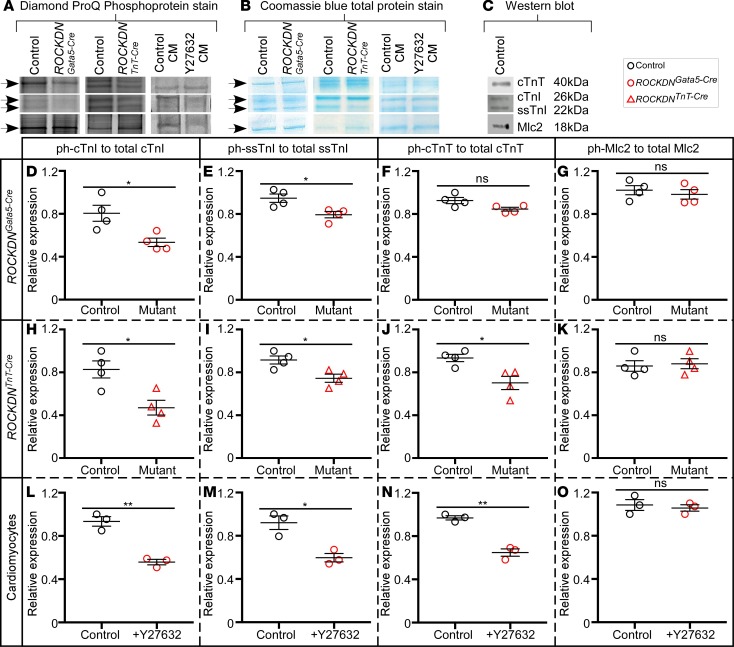
Downregulation of ROCK function leads to decreased phosphorylation of TnI and cTnT in vivo and in vitro.Pro-Q Diamond phosphoprotein stain was used to determine the total amount of the phosphorylated form of each protein (A), and Coomassie blue was used to determine total amount of each protein (B) at E13.5 in control, ROCKDNGata5-Cre, and ROCKDNTnT-Cre mutant hearts and in isolated primary mouse cardiomyocytes treated with and without the ROCK inhibitor Y27632. Representative gel images are shown for each type of sample analyzed. (C) Western blot analysis of the same blot shown in A and B, using specific antibodies, confirmed that the correct bands on the Pro-Q and Coomassie blue blots (arrows in A and B) were measured by densitometry for the proteins of interest: cTnT 40 kDa, cTnI 26 kDa, ssTnI 22 kDa, and Mlc2 18 kDa. (D–O) The relative amount of phosphorylated protein to total protein was calculated using densitometry for control and mutant heart or cell samples. A significant reduction in ph-cTnI and ph-ssTnI was observed in ROCKDNGata5-Cre (D and E) compared with controls. A significant reduction in ph-cTnI, ph-ssTnI, and additionally ph-TnT was observed in ROCKDNTnT-Cre mutants (H–J) compared with controls. Primary cardiomyocytes from E17.5 control embryos treated with Y27632 also showed a significant reduction in ph-cTnI (L), ph-ssTnI (M), and ph-TnT (N). No change in the levels of ph-Mlc2 was observed in any of the groups (G, K, and O). n = 4 for each genotype and n = 3 biological replicates for primary cardiomyocytes. Data are presented as mean ± SEM. *P < 0.05, **P < 0.01 by unpaired t test. CM, cardiomyocytes.